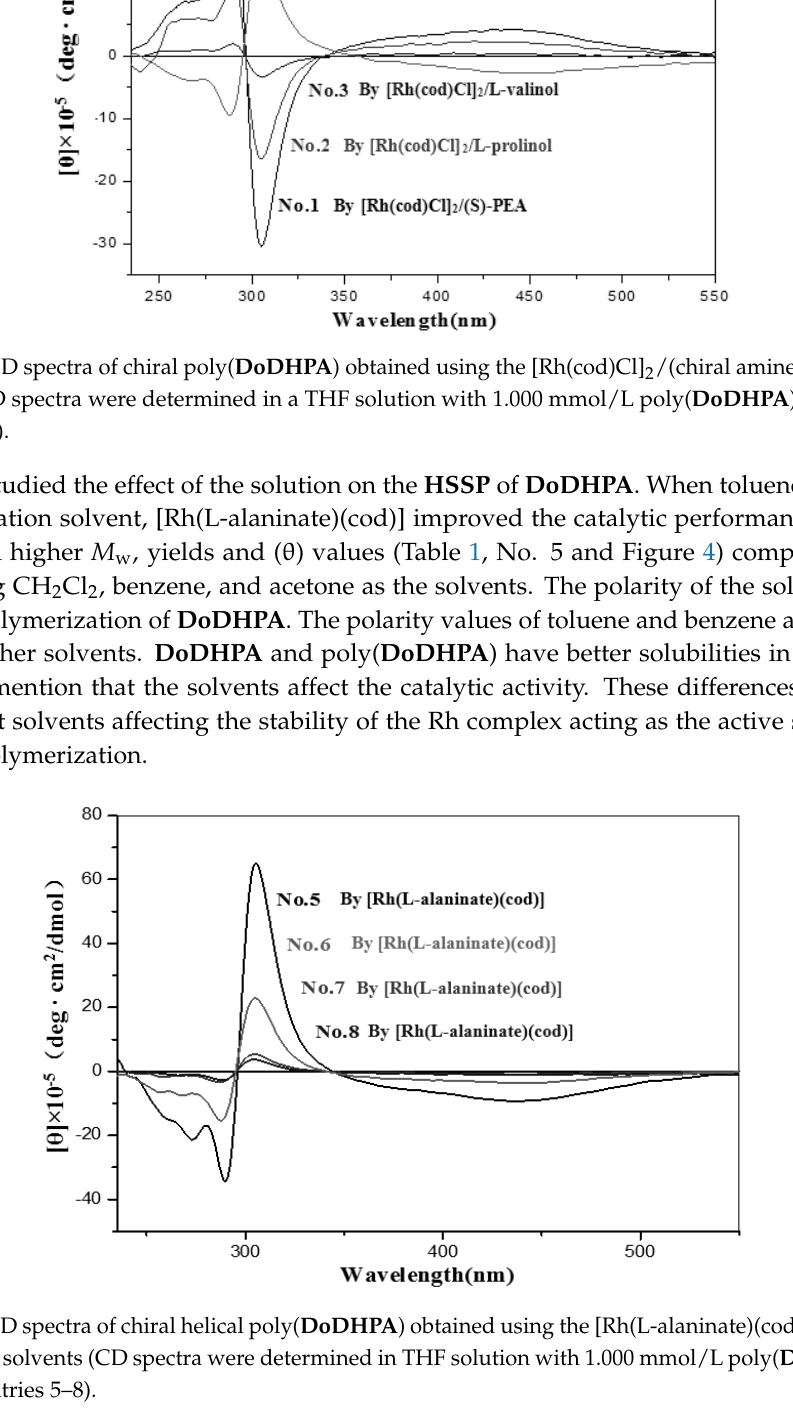
Figure 4. CD spectra of chiral helical poly( DoDHPA ) obtained using the [Rh(L-alaninate)(cod)] catalyst in different solvents (CD spectra were determined in THF solution with 1.000 mmol/L poly( DoDHPA )) (Table 1, entries 5 – 8).